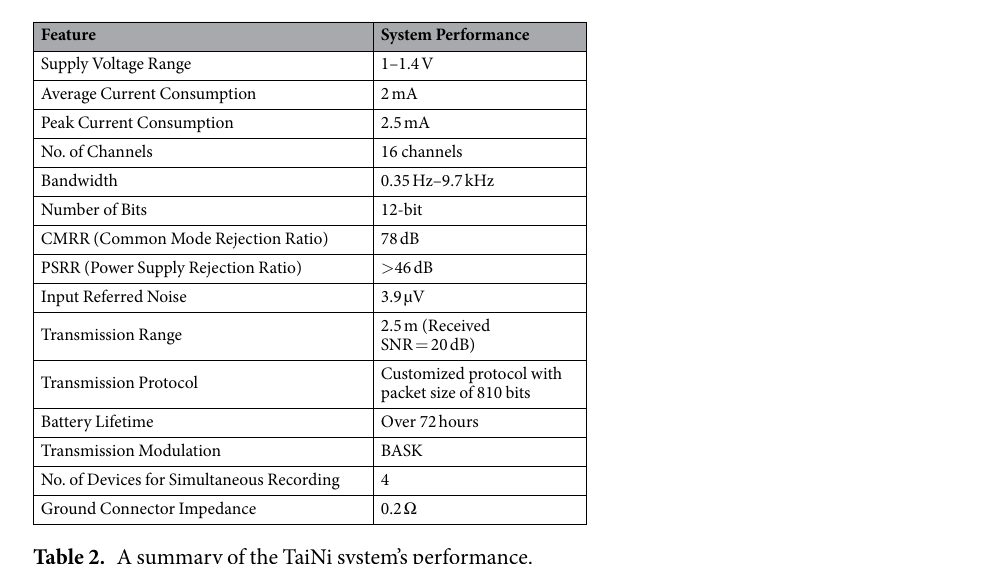
Table 2. A summary of the TaiNi system’s